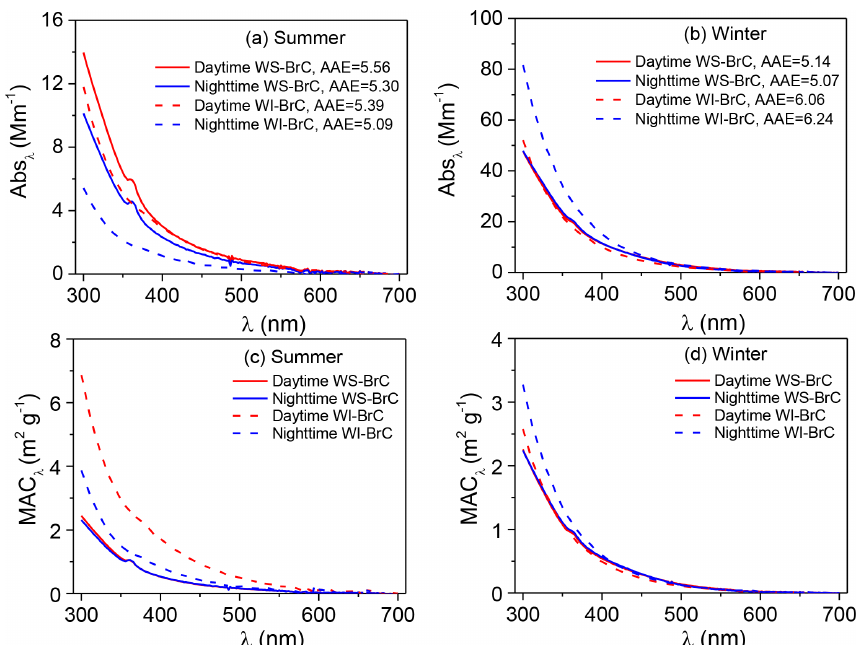
Figure 2. Average spectra of absorption coefficient (Abs λ ) (a, b) and mass absorption coefficient (MAC λ ) (c, d) of water-soluble (WS-BrC) and water-insoluble (WI-BrC) BrC during daytime and nighttime of summer and winter. Absorption Ångström exponent (AAE) is calculated by a linear regression of log Abs λ versus log λ in the wavelength range of